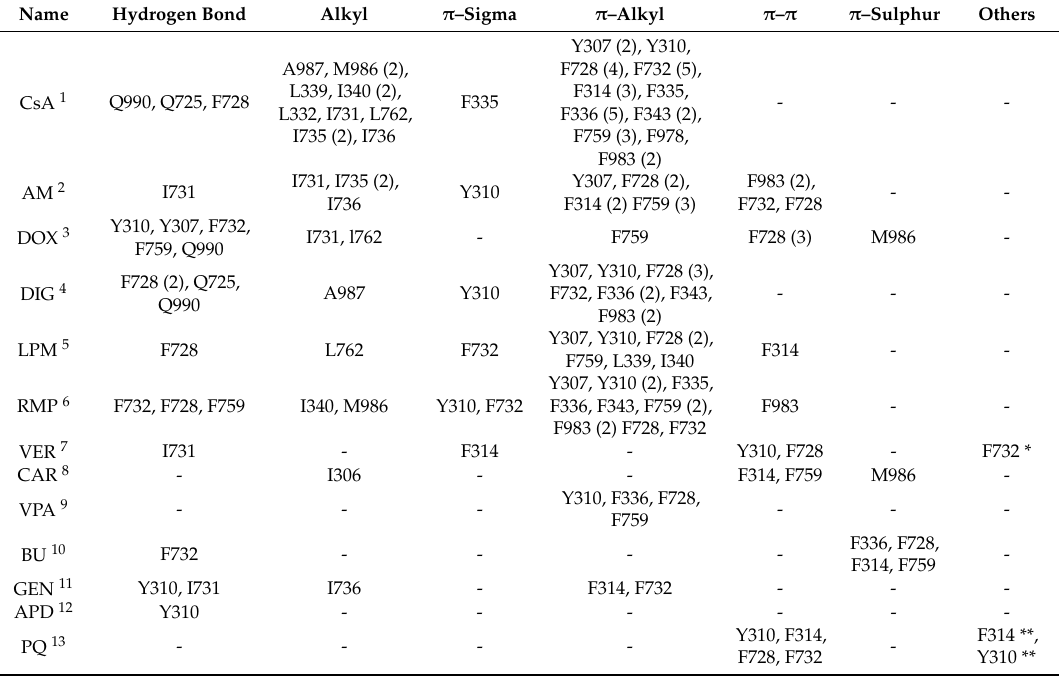
Table 14. Ligand–P-gp interaction types and amino acid residues involved in the binding of some well-known substrates and inhibitors of P-gp using the homology model. The numbers in parenthesis indicate the number of interactions in which the residue is